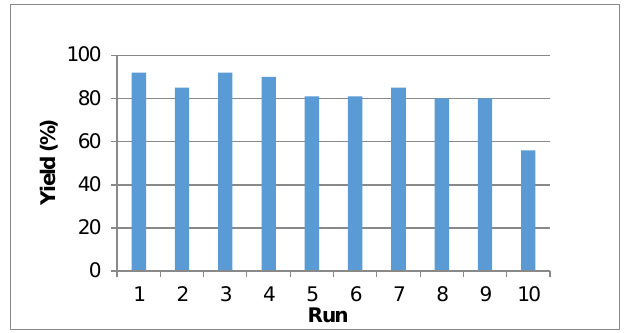
Figure 3. Results of recycling test.